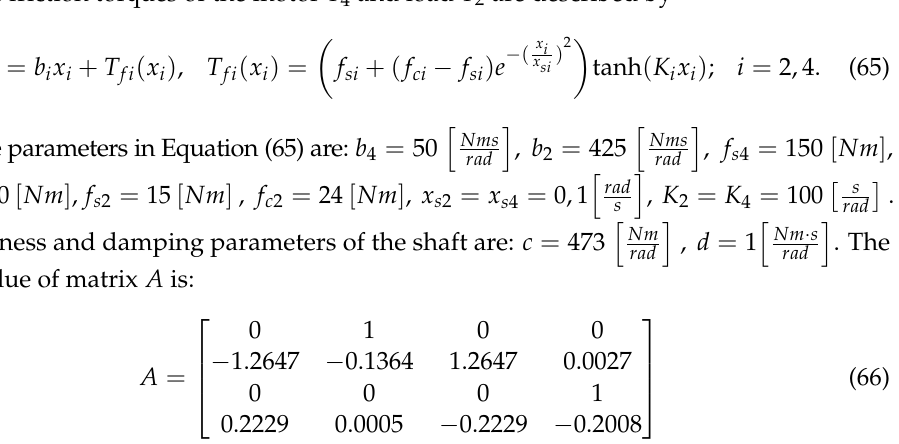
Figure 4. Schematic diagram of a drive with an elastic coupling.